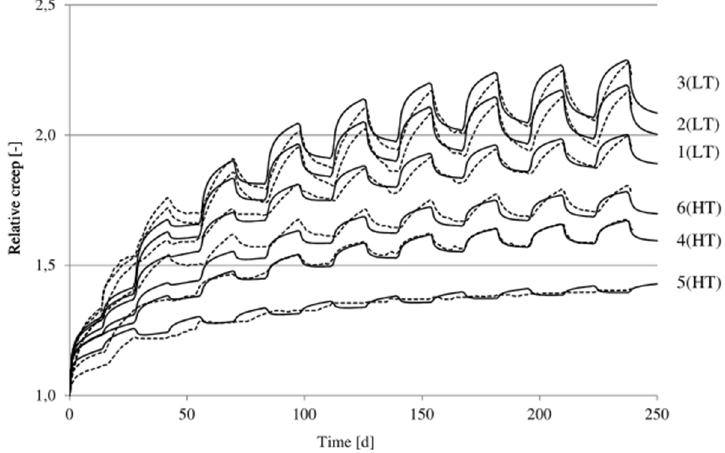
Figure 5. Relative creep of the LT and HT specimens. Test (dashed lines) vs. Simulation (cont. lines) [81].